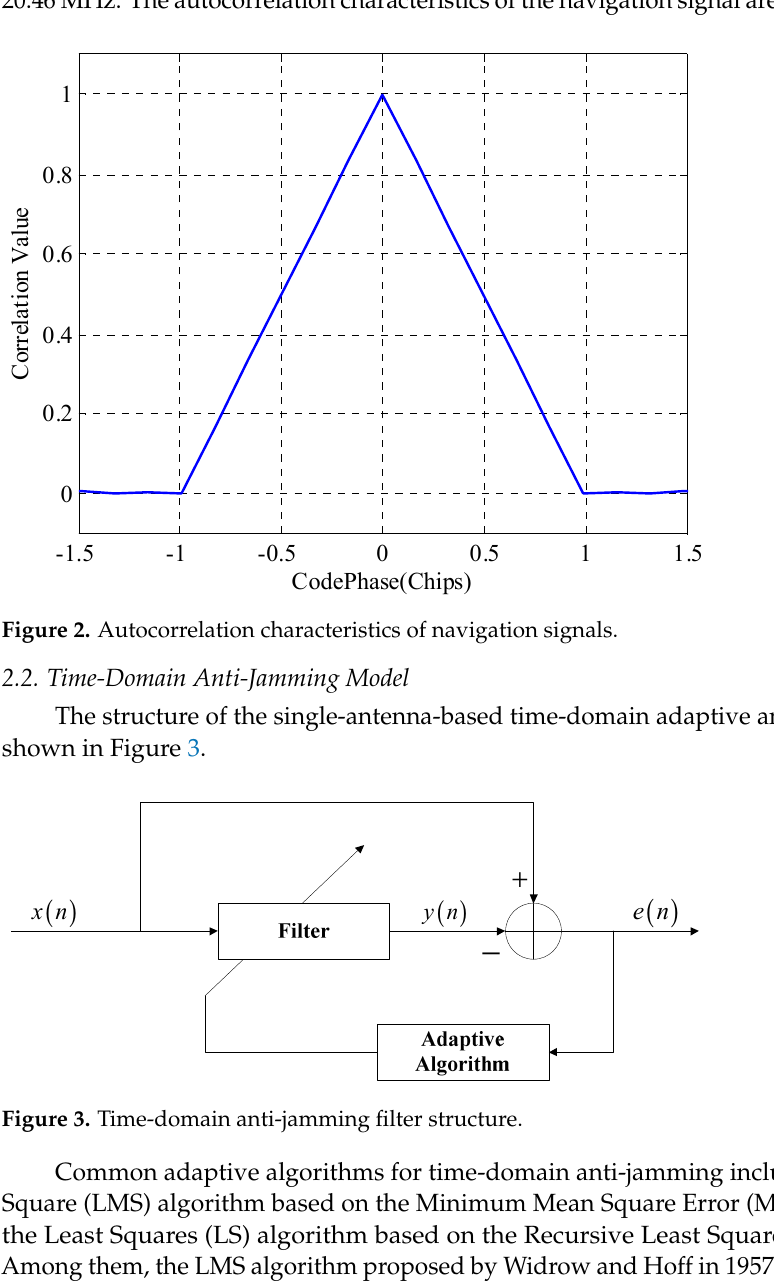
Figure 1. Spectrum comparison of interference, signal and noise. ( a ) Independent shown, ( b ) Syn- thetic shown. The code rate of the Beidou B3I signal is 10.23 MHz, and its signal bandwidth is 20.46 MHz. The autocorrelation characteristics of the navigation signal are shown in Figure 2.